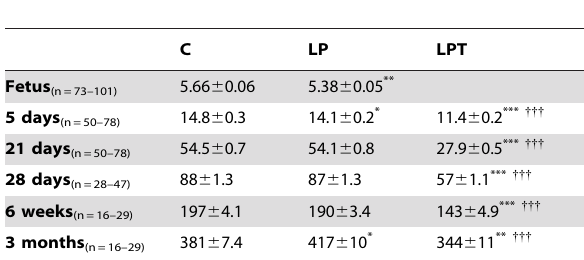
Table 1. Body weights of fetuses (21.5 days of gestation) and postnatal rats.